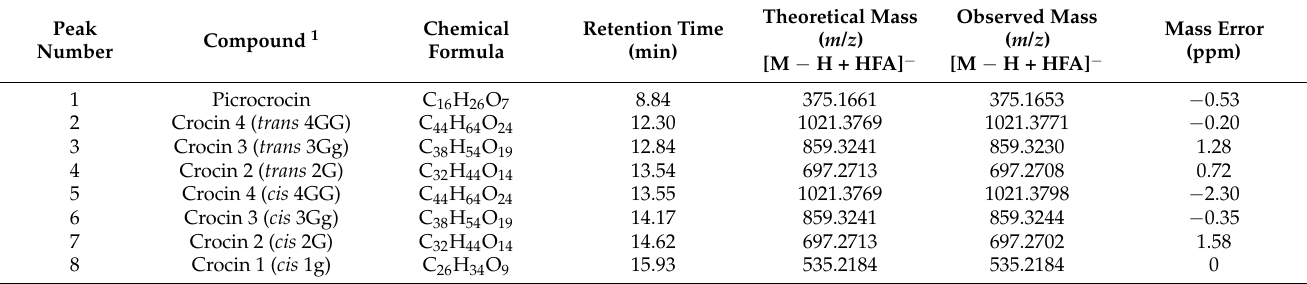
Table 2. Compounds identified by LC-Q-TOF/MS in picrocrocin and crocin solutions obtained from